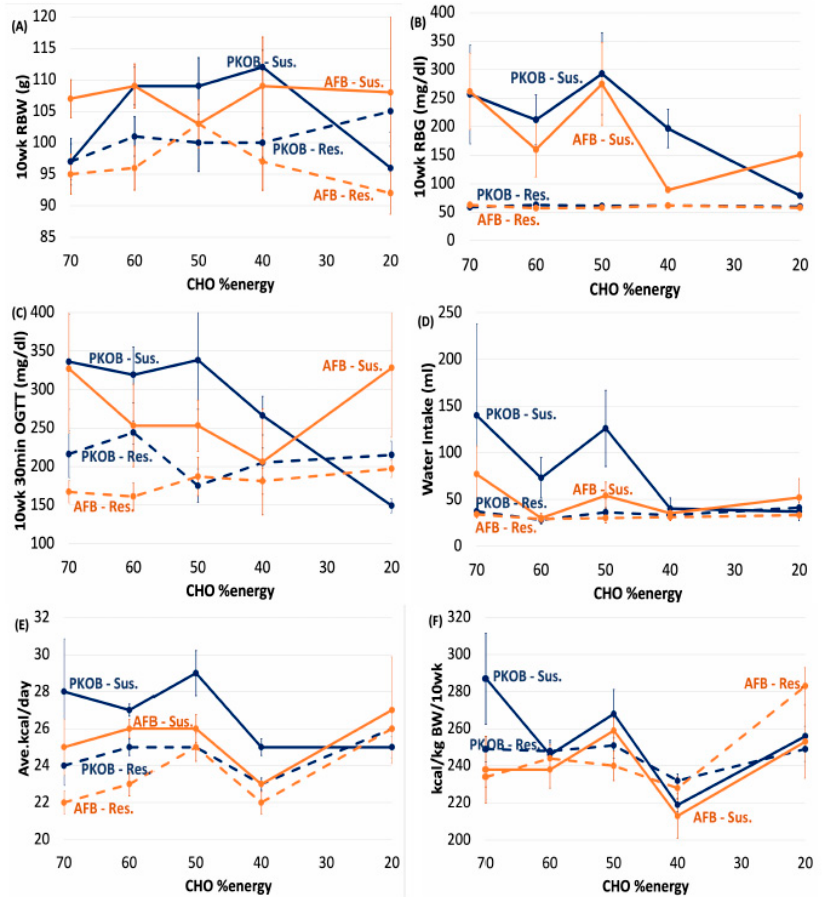
Figure 3. Clinical data for all rats reflect diabetes induction by PKOB (blue) and AFB (orange) as a function of the CHO:fat ratio on the X-axis. Genetic permissiveness was expressed as rats resistant (dashed lines) and susceptible (solid lines) to diabetes. ( A ) RBW for resistant rats was less than that for susceptible rats for both PKOB and AFB. The weight difference was most striking for AFB, where susceptible rats weighed substantially more than resistant rats. ( B ) RBG for all resistant rats was normal, around 50 mg/dL, whereas susceptible groups fed PKOB expressed more diabetes than susceptible rats fed AFB (42% vs. 29%), which was in keeping with overall more diabetes in PKOB rats overall. ( C ) The 30 ′ OGTT revealed the most diabetes (>175 mg/dL) at 70, 60, 50 and 40 CHO %energy, with less diabetes in resistant rats fed AFB than PKOB at 70 and 60 CHO %energy intakes. In general, the 30 ′ OGTT is more sensitive to detecting early diabetes than RBG. ( D ) Water intake was normal for both groups of resistant rats, but was most elevated in susceptible rats fed PKOB at 70, 60 and 50 CHO %energy, when the diabetes was most pronounced. ( E ) Average kcal/day intake was consistently greater for susceptible rats fed 70, 60, 50 and 40 CHO %energy compared to resistant rats for both fats. However, at the greatest fat intake, i.e., 20% CHO, 60% fat, caloric intake was similar for all rats. In general, susceptible rats consumed more than 25 kcal/d, while resistant rats ate 22–25 kcal/d. ( F ) When caloric intake was adjusted for BW, PKOB rats at 70 CHO %energy ate more calories than all other rats (except for a lone resistant outlier fed AFB at 20 CHO %energy as CHO). Differences between PKOB and AFB decreased as CHO %energy decreased and fat intake increased (see Tables S5 and S6 for